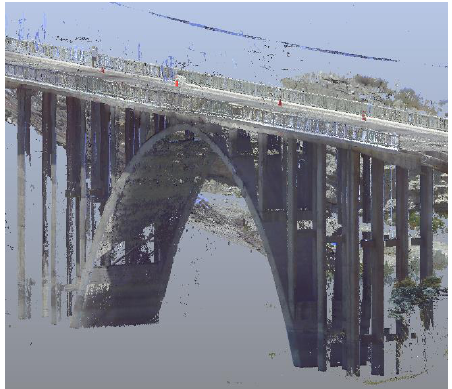
Figure 4: The screenshot of the software prototype that displays the damage detection results of the selected